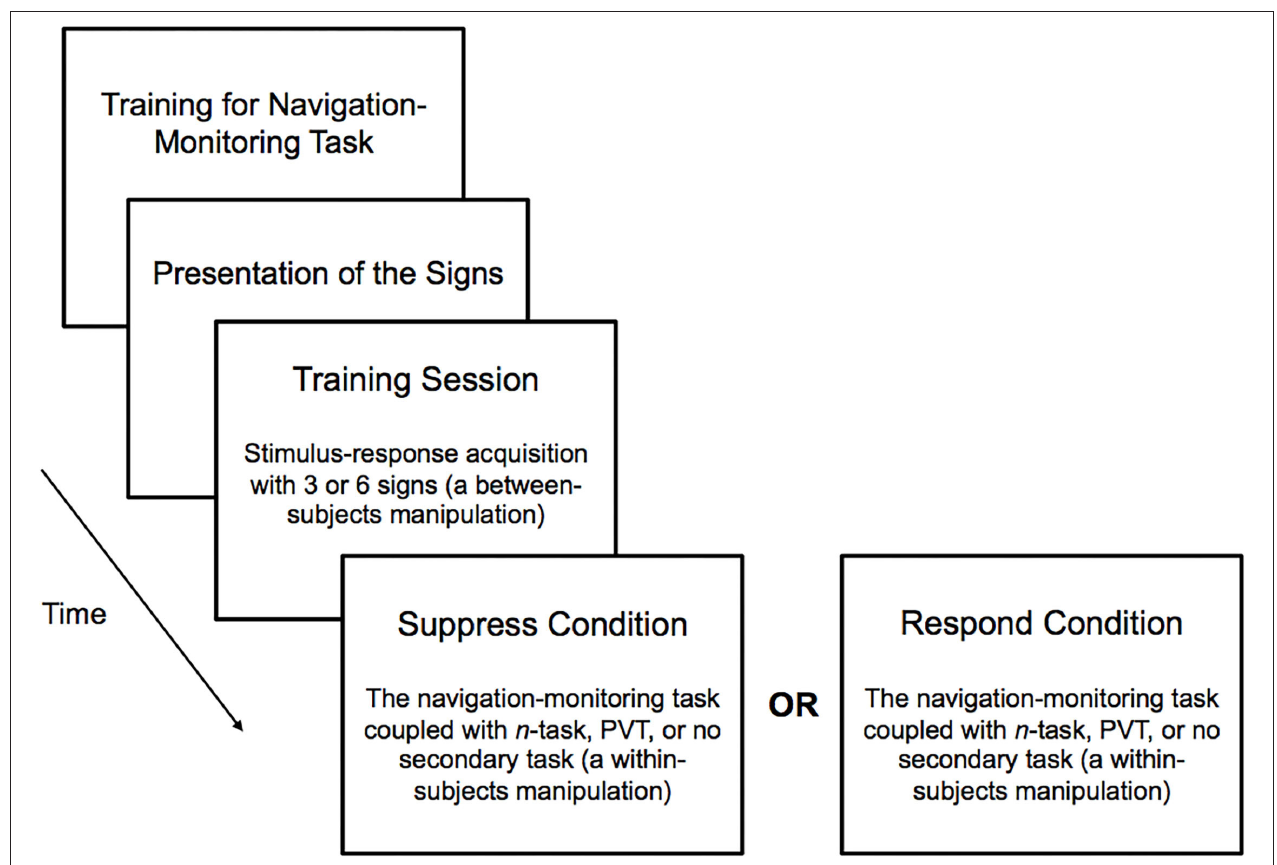
FIGURE 4 | Schematic depiction of sequence of events composing the experimental